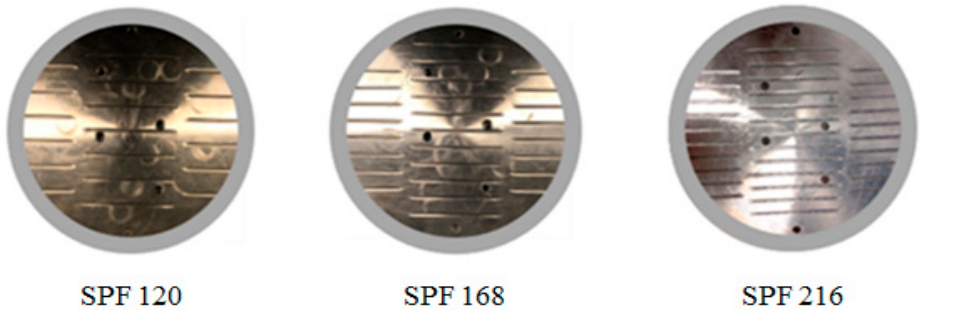
Figure 4. Slotted liner coupons.